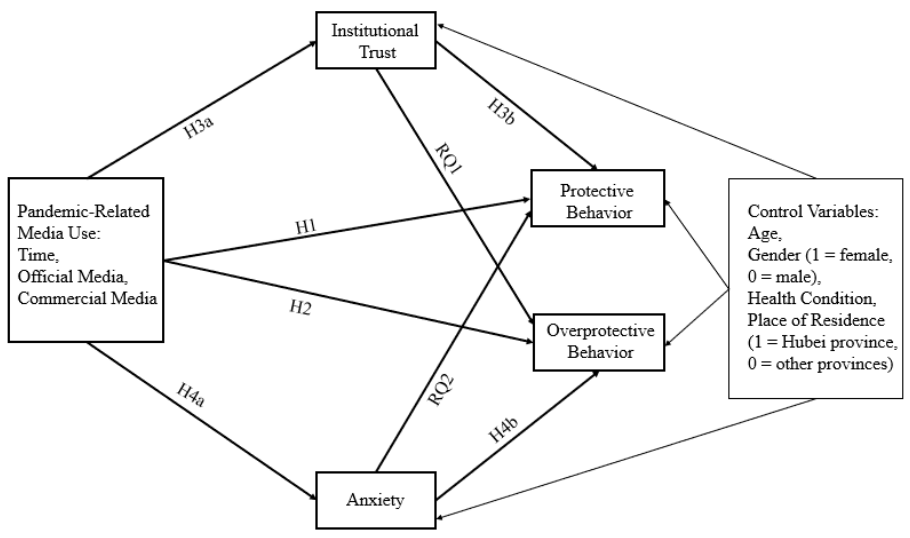
Figure 1. Conceptual